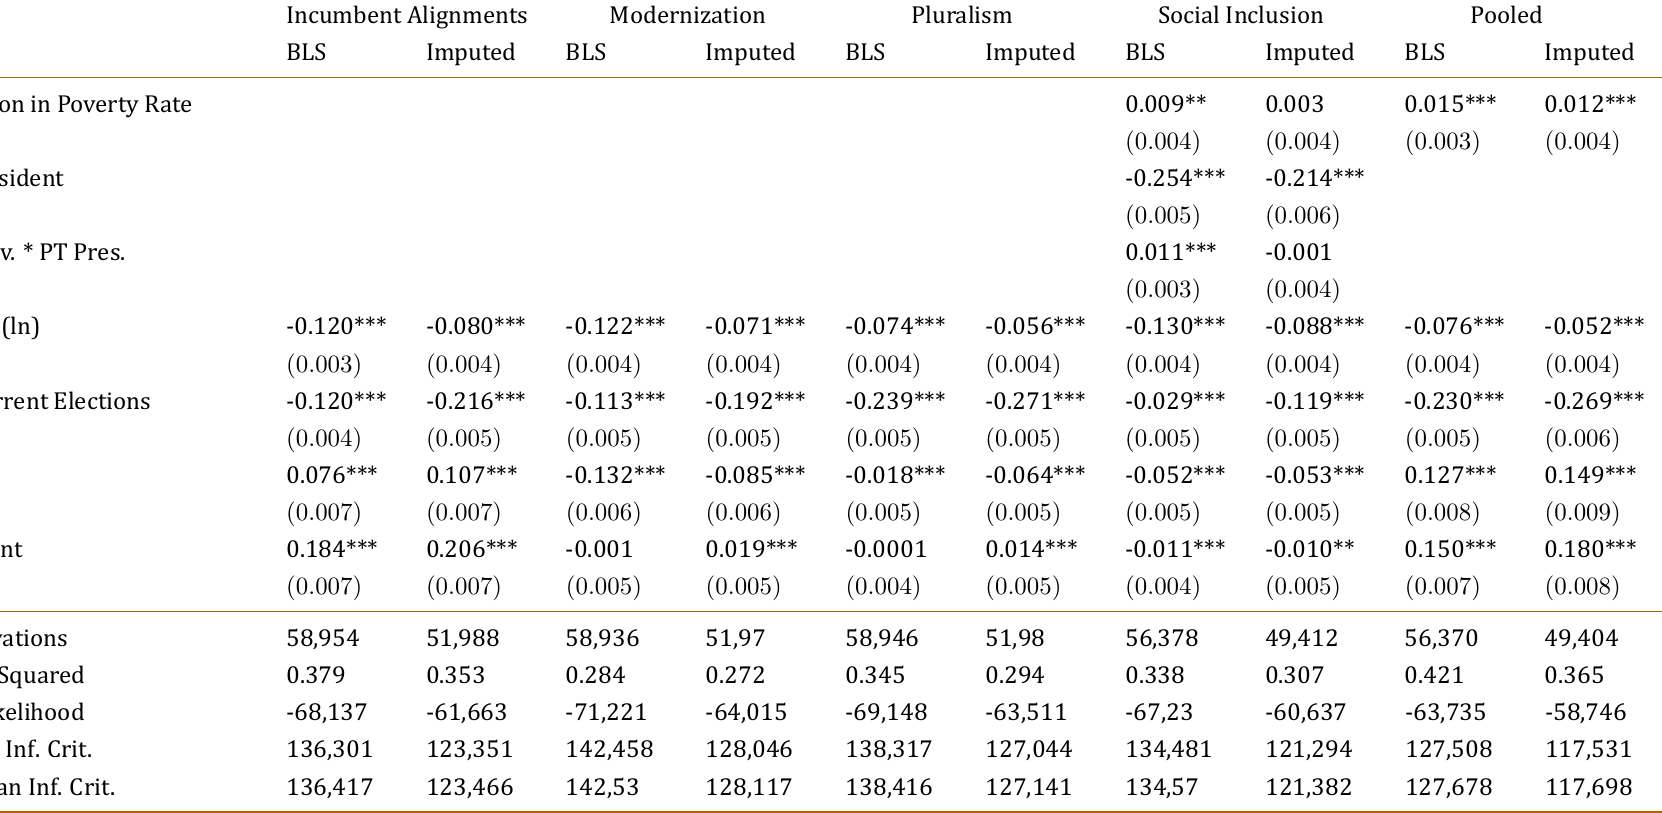
Table 1: GLS regressions for the municipal ideological score (z-scores) (continuation) Incumbent